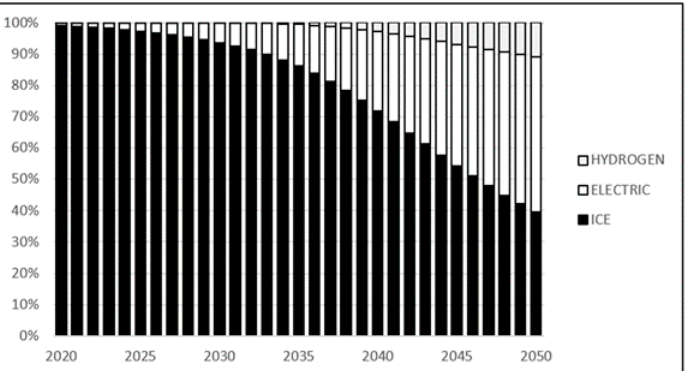
Figure 1. Structure of passenger cars in Poland in the years 2020–2050 by engine type according to Rabiega et al. (2021) [22].